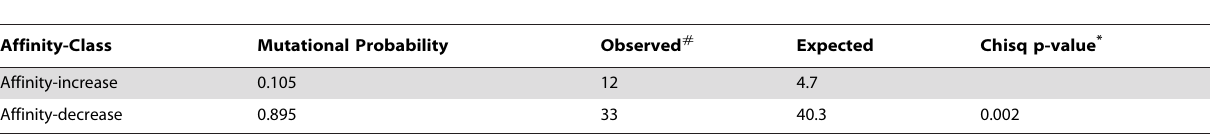
Table 1. Mutational probability of affinity increase and affinity